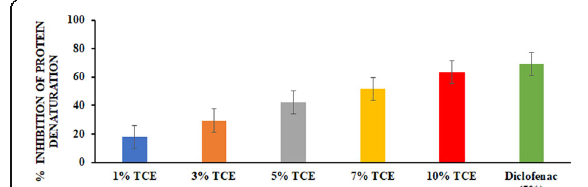
Fig. 4 Percentage inhibition of protein denaturation of the TCE samples relative to Diclofenac (5%)